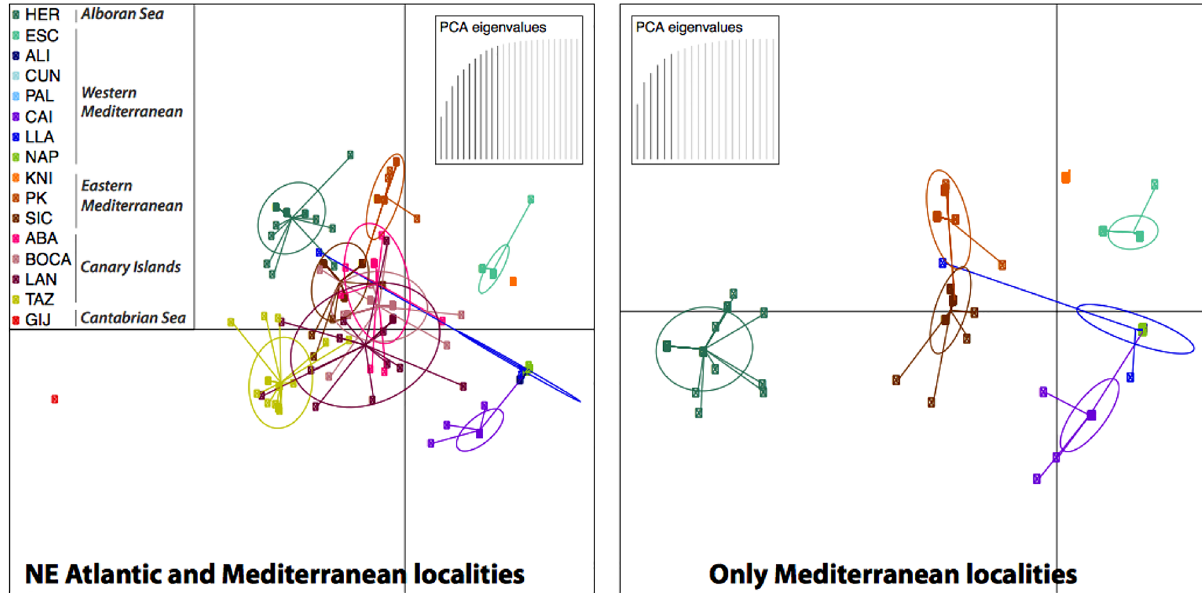
Figure 4. DAPCs of C. tenuispina . Graphs depict DAPC results based on sampling localities from two datasets: including all individuals and geographical areas (left graph), and only Mediterranean localities (right graph).